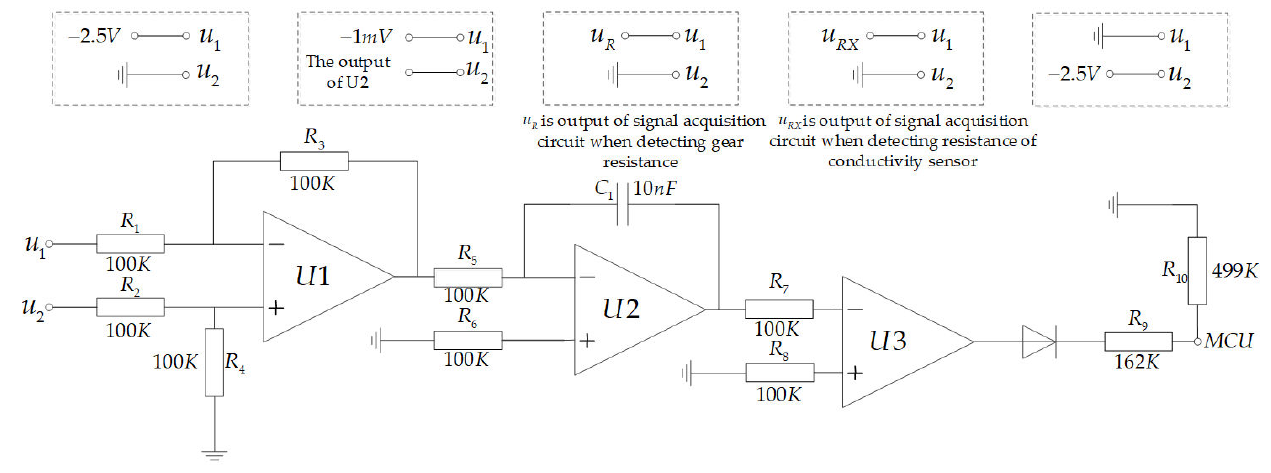
Figure 6. Schematic diagram of the measurement